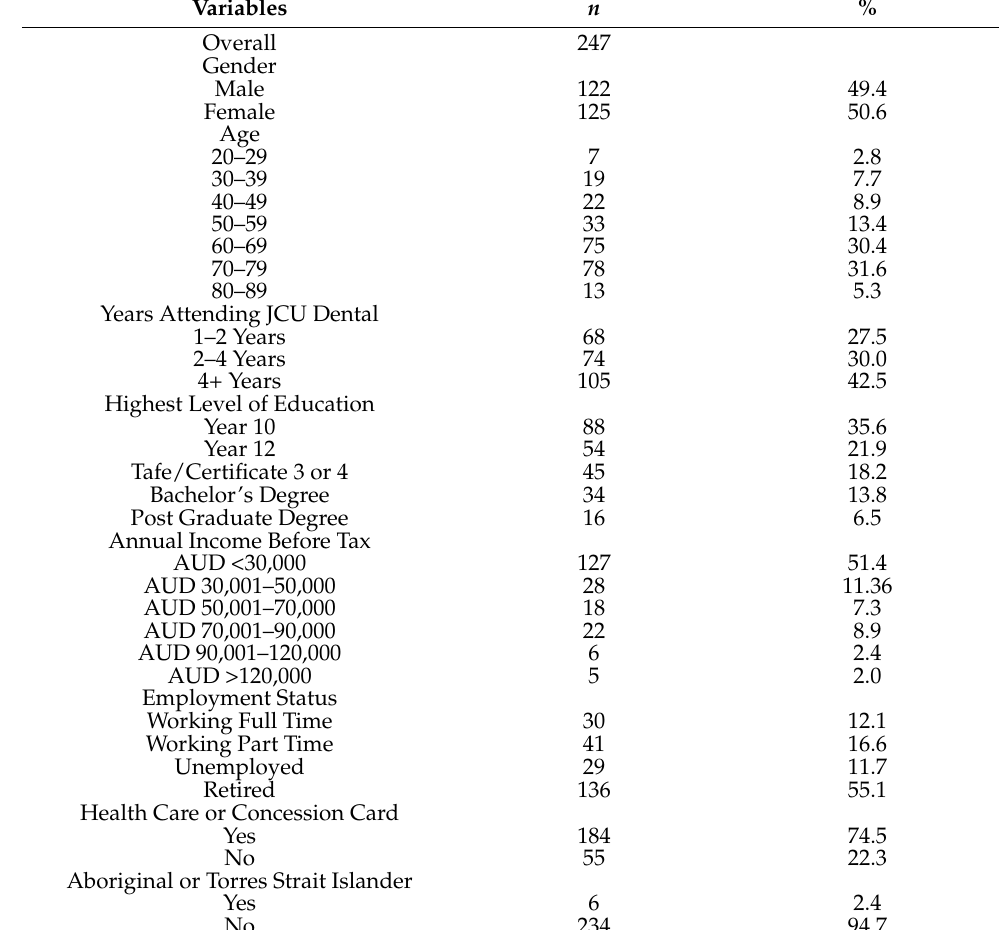
Table 1. Socio-demographic characteristics of the study participants. Variables n